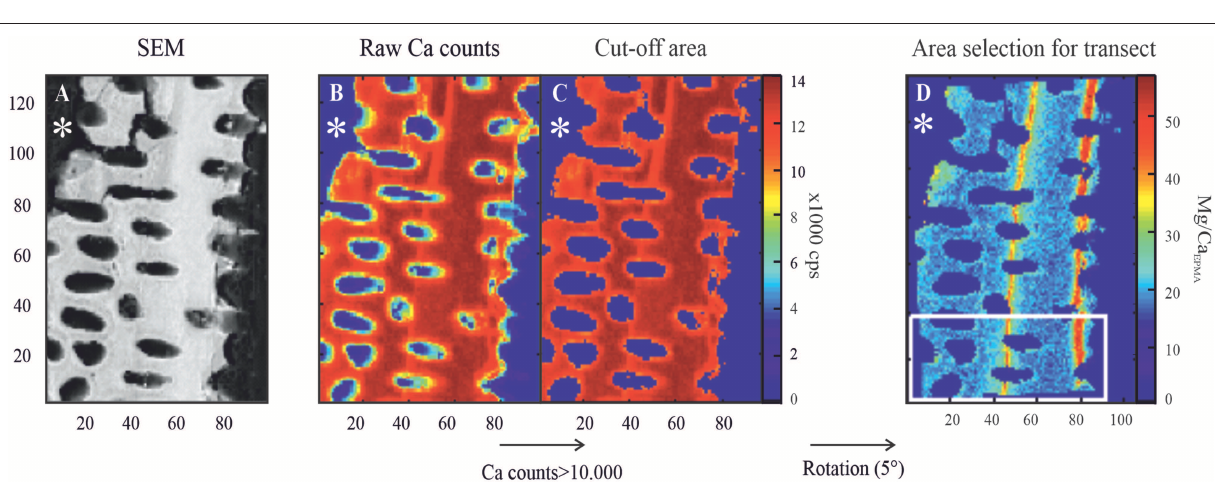
FIGURE 2 | Example of EPMA data treatment from a specimen of Amphistegina lessonii (F-2) with an asterisk indicating outer side of the test. (A) SEM image of the area of interest. (B) Map of raw Ca counts (cps). (C) Resulting Ca matrix after cutoff at 10,000 cps, removing resin, and pore areas, as well as potential edge effects. (D) Mg/Ca map is rotated (in this example, 5 ◦ ), and a rectangular area perpendicular to the test wall is selected for transect analysis. EPMA, electron probe microanalysis; SEM, scanning electron